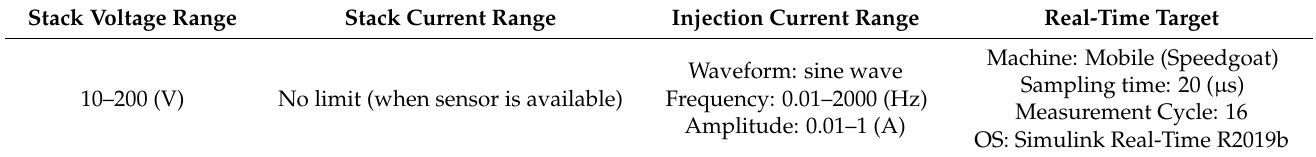
Table 1. Operation specification of the proposed